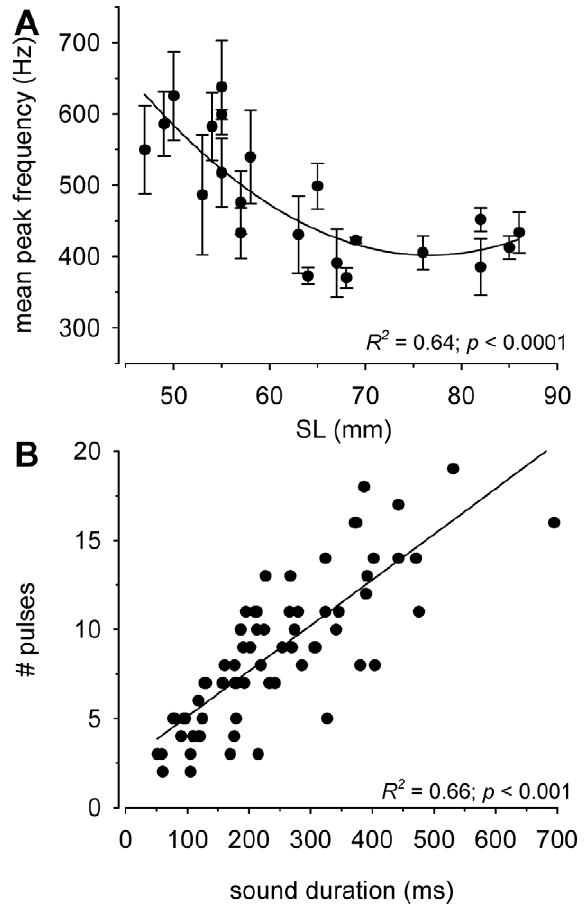
Figure 3. Characteristics of courtship sounds produced by male A.burtoni during quiver behaviors. A) Relationship between mean peak frequency (Hz) of sounds and male body size (standard length) shows that larger males produce lower frequency sounds. Each point represents the mean 6 SE of several sounds produced by an individual fish. B) There is a positive linear relationship between the number of pulses per sound and total sound duration (ms). doi:10.1371/journal.pone.0037612.g003 PLoS ONE |